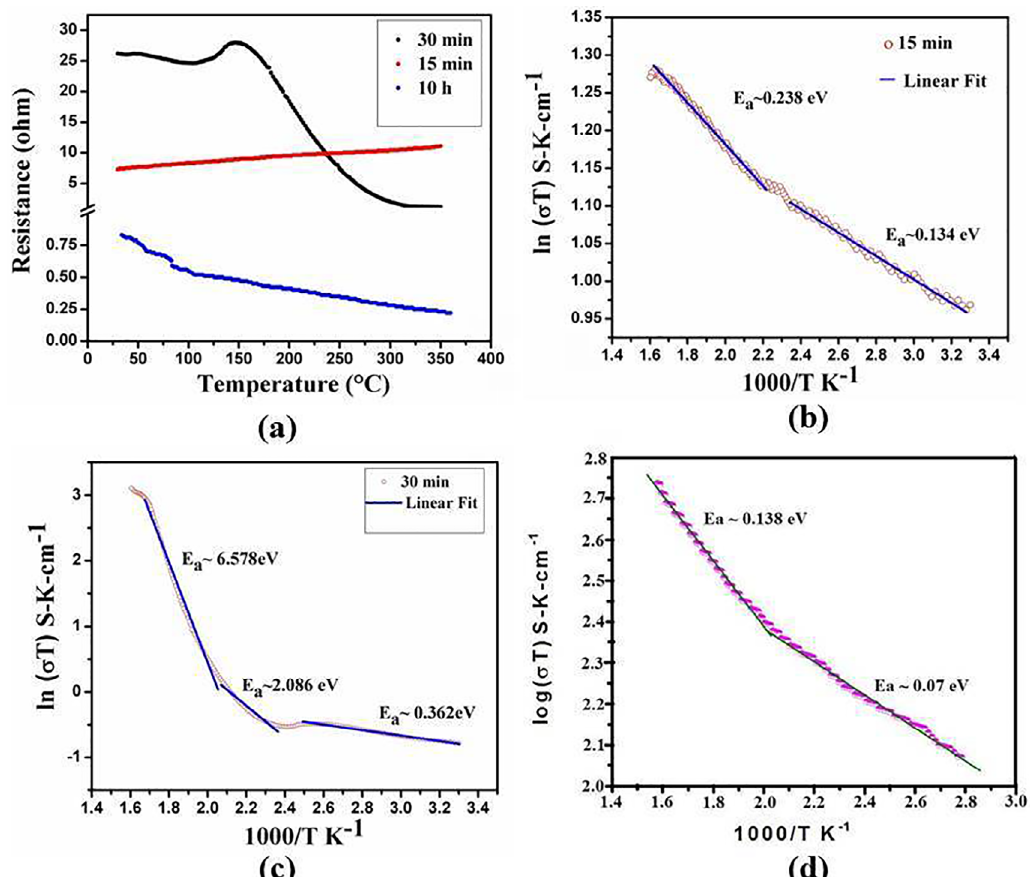
Figure 7. (a) Variation of DC resistance of 15min, 30min and 10h milled samples with temperature (b) Activation energies of 15min ball milled sample at different temperature regions (c) Activation energies of 30 min ball milled sample at different temperature regions (d) Plot of log σT with 1000/T after measurement the DC electrical conductivity of 10h ball-milled Bi